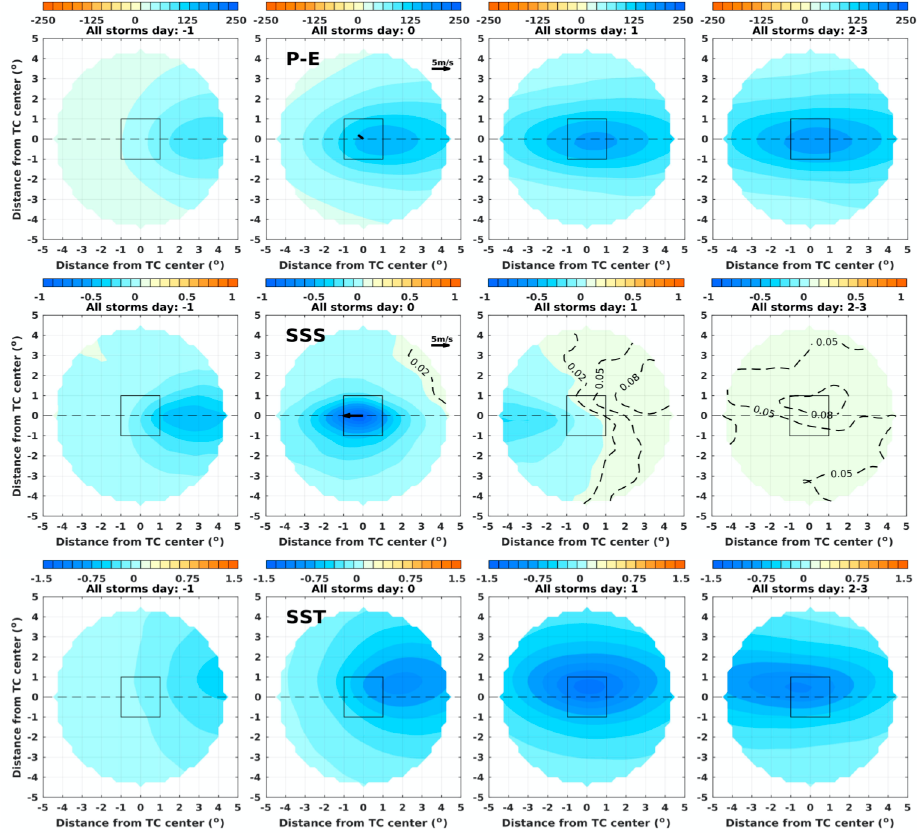
Figure 4. (upper panels) Distribution of the accumulated P-E (mm; precipitation-evaporation) from day − 2. The vector on day 0 shows the composite vertical wind shear, which is 1.54 m s − 1 . (middle panels) Distribution of the SSS anomaly (psu), using SMAP swath daily data (L2C) with surface wind higher than 15 m s − 1 associated SSS removed. The composite translation speed is 5.18 m s − 1 shown on day 0. Contours show the positive SSS anomaly with contour interval 0.03 psu. (lower panels) Distribution of the SST anomaly ( ◦ C). All TCs in the Northern Hemisphere from March 2015 to December 2019 are used for composite analysis.